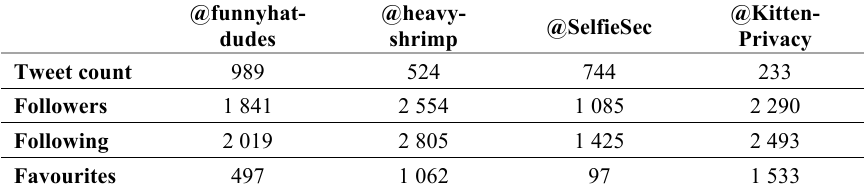
Table 2. The numbers of tweets including retweets, followers, following (followed users) and favourites of the four case